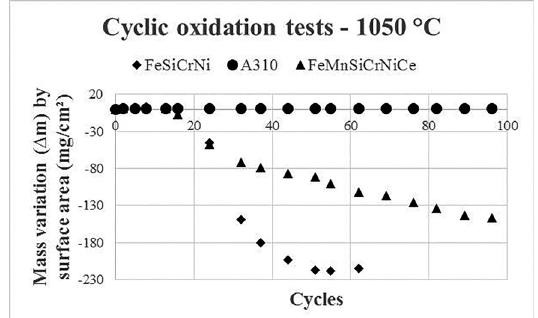
Figure 3. Mass variation by surface area versus number of cycles in cyclic oxidation test at 1050